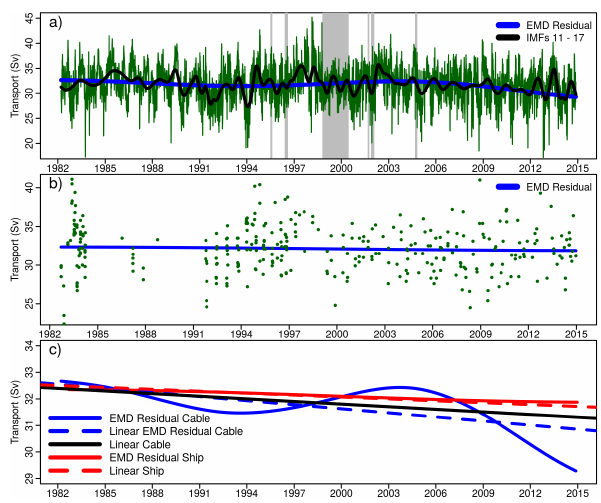
Figure 2. (a) Florida Current daily transport estimates from induced cable voltages at 27 ◦ N (green). The gray background bounds miss- ing measurements and data reconstructed from daily distributions across all available years. Also shown are the sum of the EMD resid- ual and IMFs 11–17 (black), and the EMD residual itself (blue). The total number of IMFs is N IMF = 17. (b) Florida Current transport estimates from ship-based measurements (green) and EMD resid- ual (blue). (c) Comparison of EMD residuals to linear models of the transport data, and to a linear model of the cable transport EMD